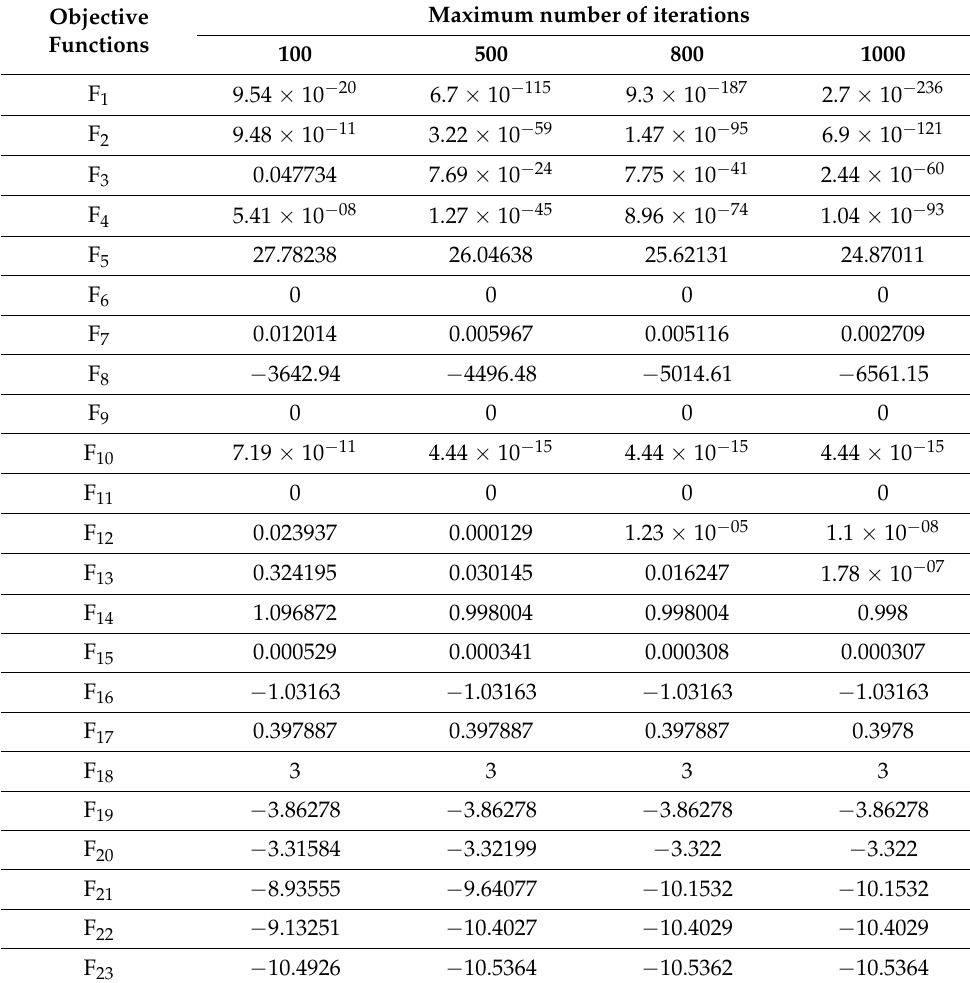
Table 9. Results of the algorithm sensitivity analysis to the maximum number of